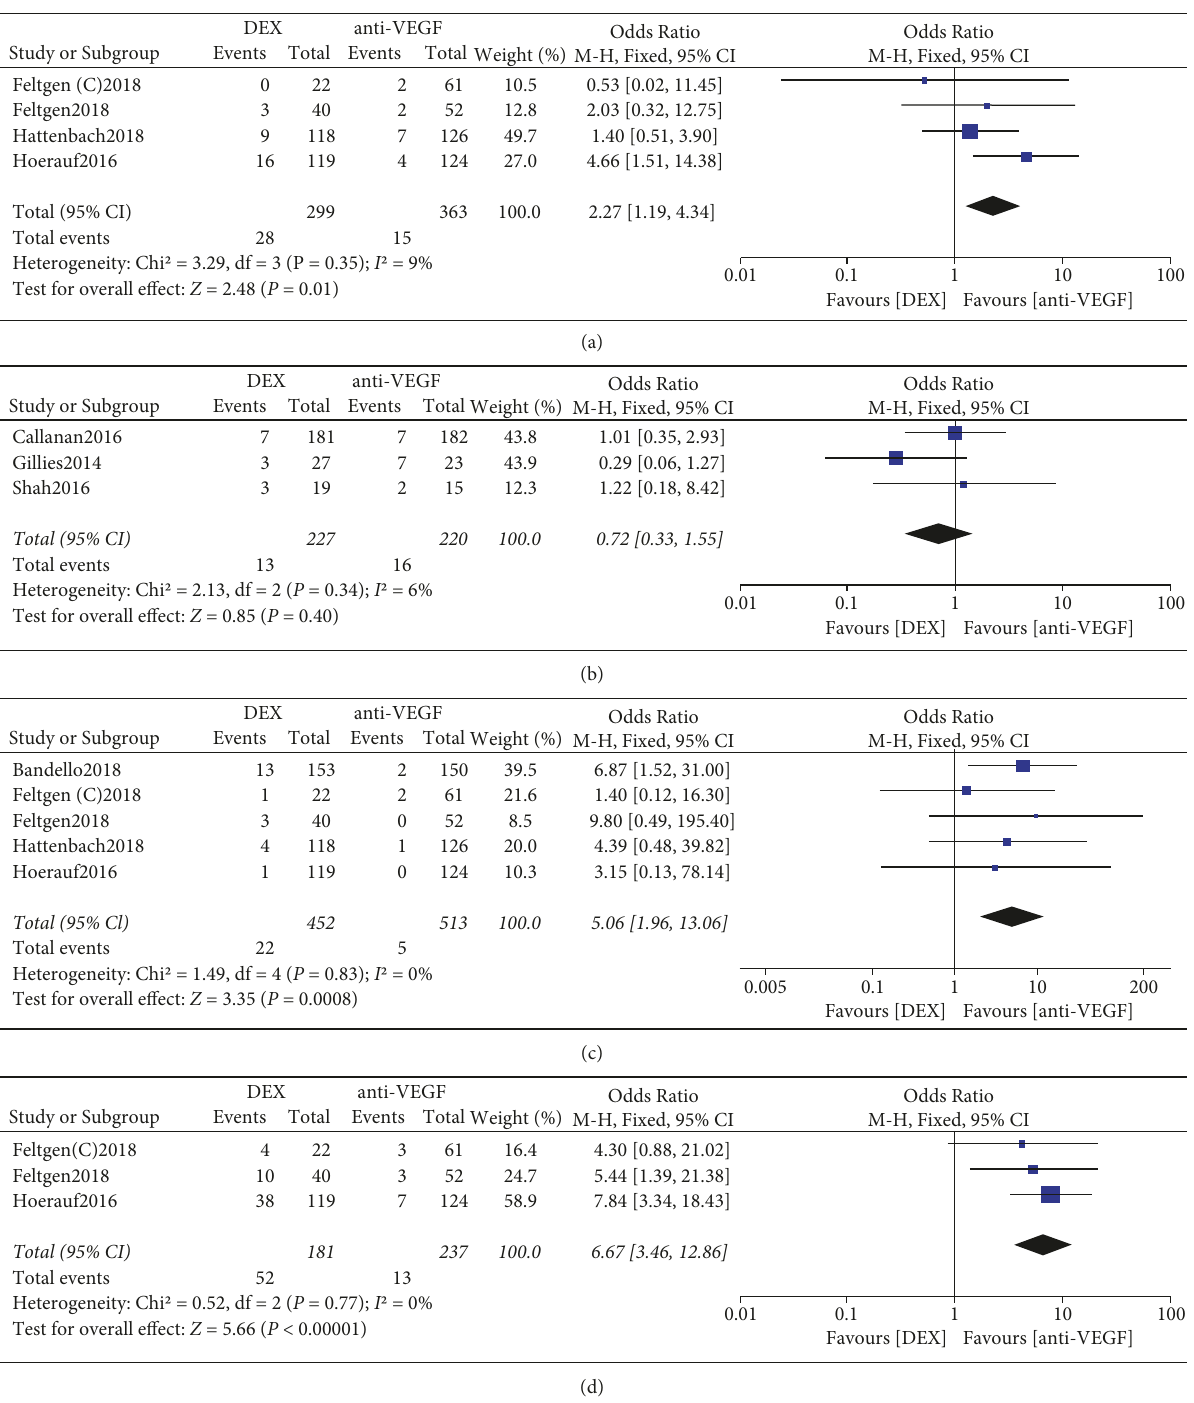
Odds Ratio M-H, Fixed, 95%